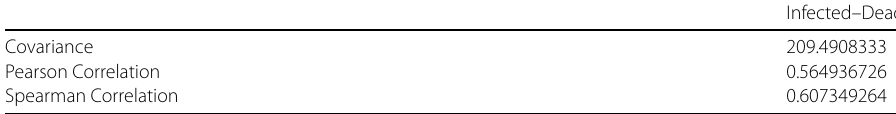
Table 4 Some data for coronavirus cases in South Africa